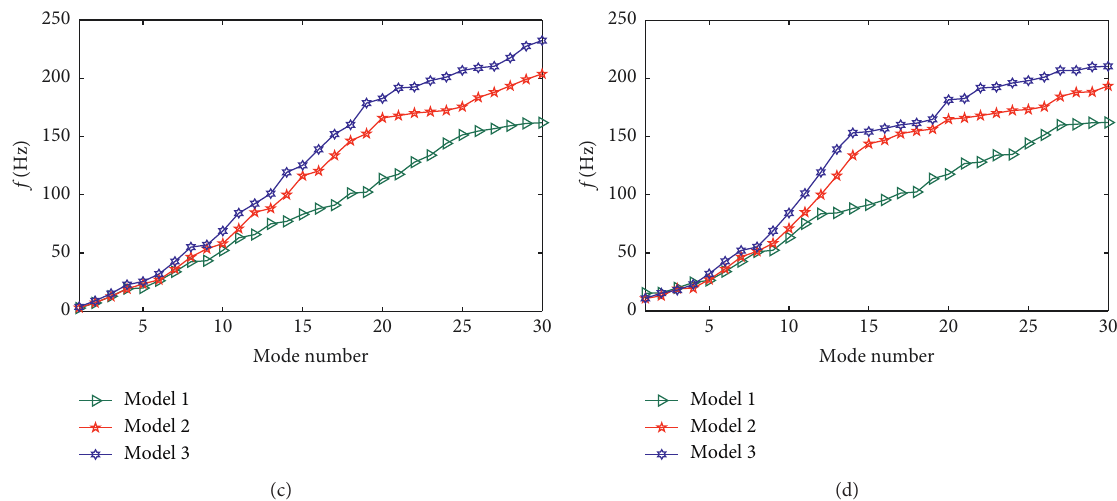
Figure 14: Frequency curves of the first 30 orders of three conical shells with variable cone angle under different boundary conditions. (a) Table 6: Frequencies of conical shell-annular plate structure under different boundary conditions. Boundary condition m